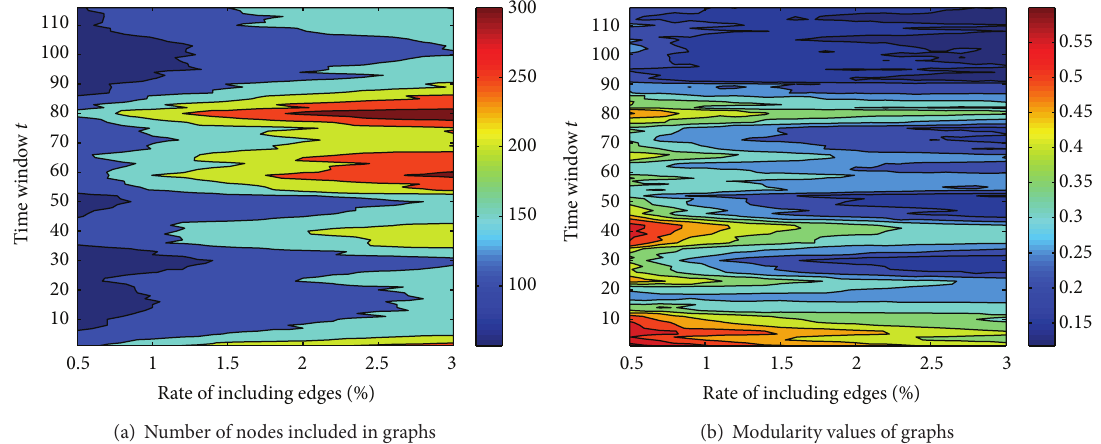
Figure 4: (Color online) Contour plots of node numbers and modularity values of graphs versus rate of including edges and 𝑡